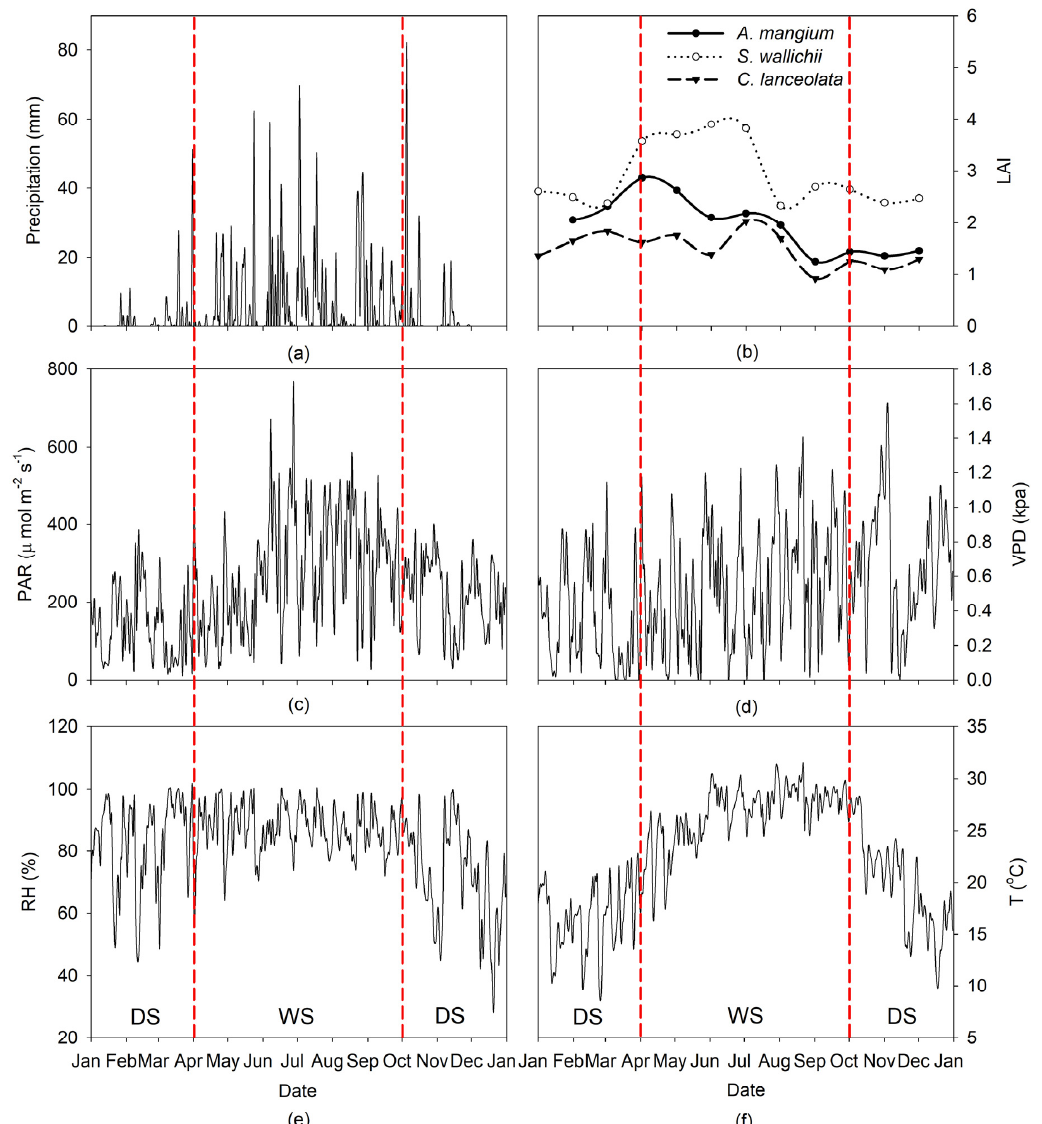
Figure 1. ( a ) Daily precipitation, ( b ) monthly leaf area index (LAI), daily mean values of ( c ) photosynthetically active radiation (PAR), ( d ) vapor pressure deficit (VPD), ( e ) relative humidity (RH) and ( f ) temperature ( T ) during dry season (DS) and wet season (WS) in 2017.